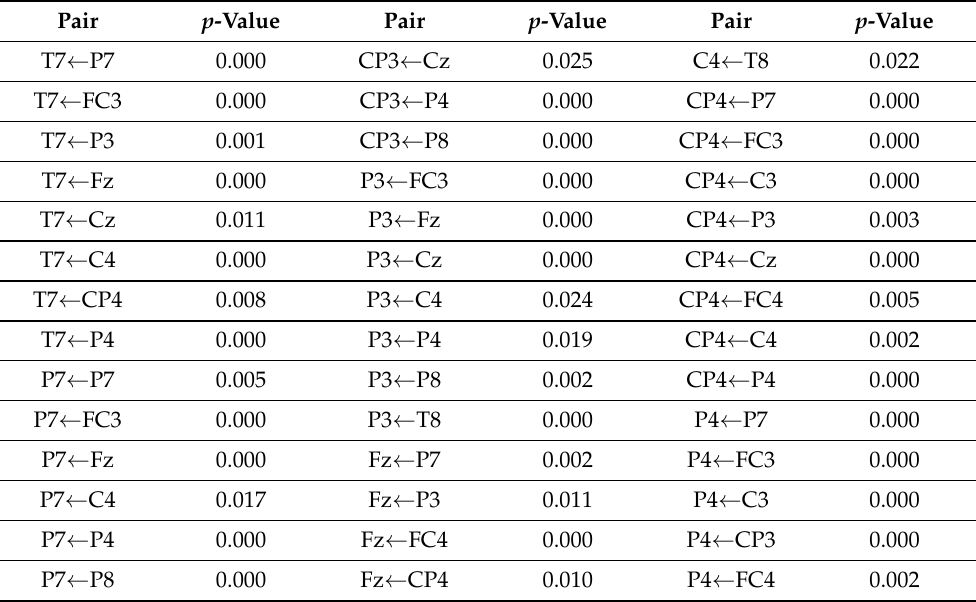
Figure 6. Matrix-form illustration of 105 significant connections (in green) listed in Table 1. The statistical analysis showed that 105 out of the 196 connections were identified as significant with a 95% confidence level. With more than half (55.6%) of the connections at the 95% confidence level, the classification of the left/right MI EEG based on the 14 electrodes is expected to give good performance. Table 1 provides the p -value of the significant pairs. As described in Section 4.5, a p -value that is less than 0.05 basically indicates that the difference between the classes of the said connections is significant. This implies that the significant connections are dominant PDC features that largely contribute to the high classification accuracy of the proposed method. Table 1. List of p -values of 105 significant connection